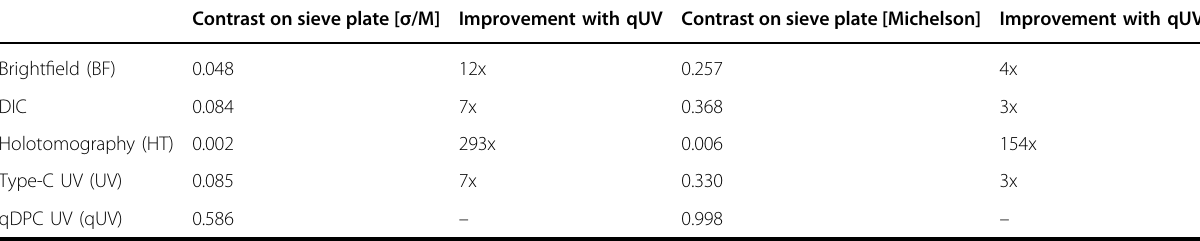
The metric for contrast was either the standard deviation σ of pixel values in the sieve plate region, normalized by the median value M or the approach by Michelson (peak-to-peak)